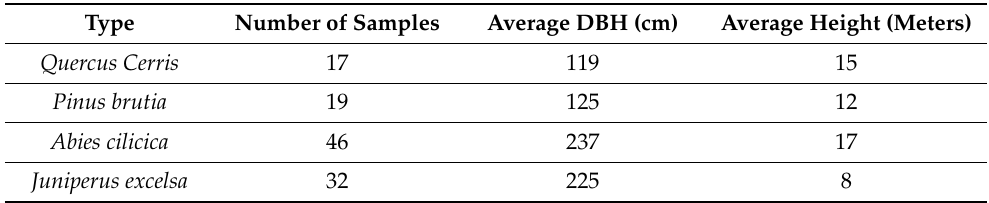
Table 1. Information about the collected field